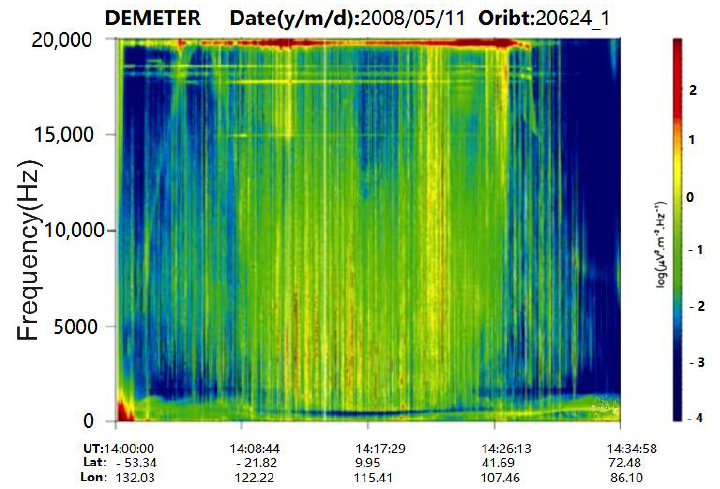
Figure 1. The spectrogram of the electric field component of the VLF electromagnetic signal received by the EFD of the DEMETER satellite passing by the epicenter on 11 May 2018 .